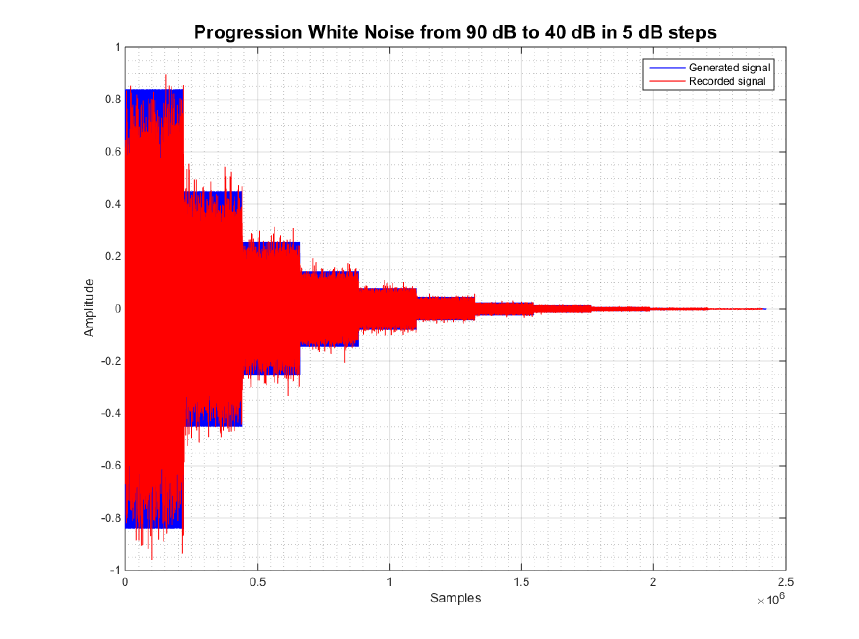
Figure 7. Waveform from the readings from the sound level meter and readings from the device. Table 2. Levels from the sound level meter and the Raspberry Pi 2 Model B device (dB) for 15 s. Rion